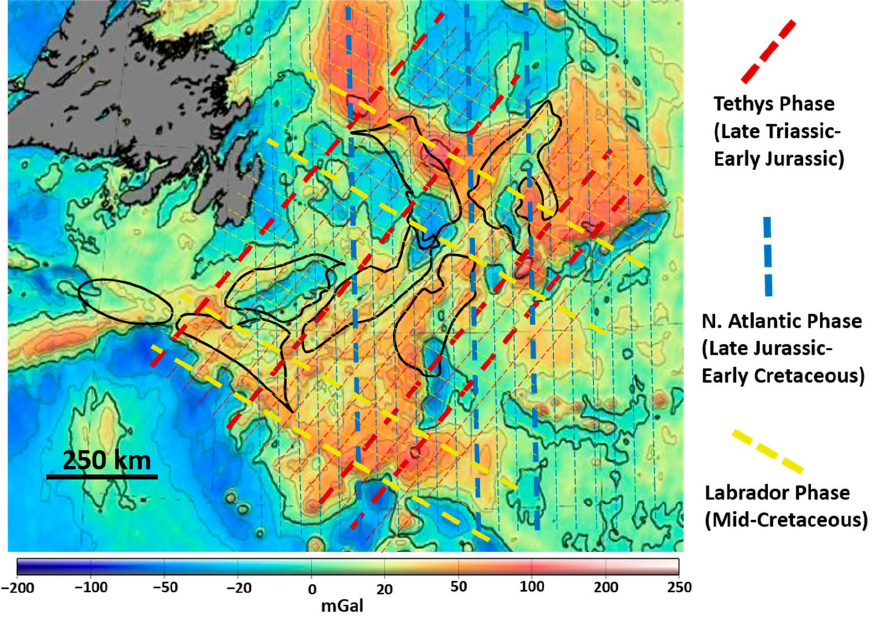
Figure 6. 1 arc-minute resolution gravity anomaly map of the Grand Banks with elongated structures highlighted by dashed lines spaced 50 km apart. Colors of lines correspond to rifting episodes indicated on the right and are parallel to each rift axis orientation. Bold lines indicate better qualitative fit. Basin footprints adapted from [5], global gravity anomaly data from [57].